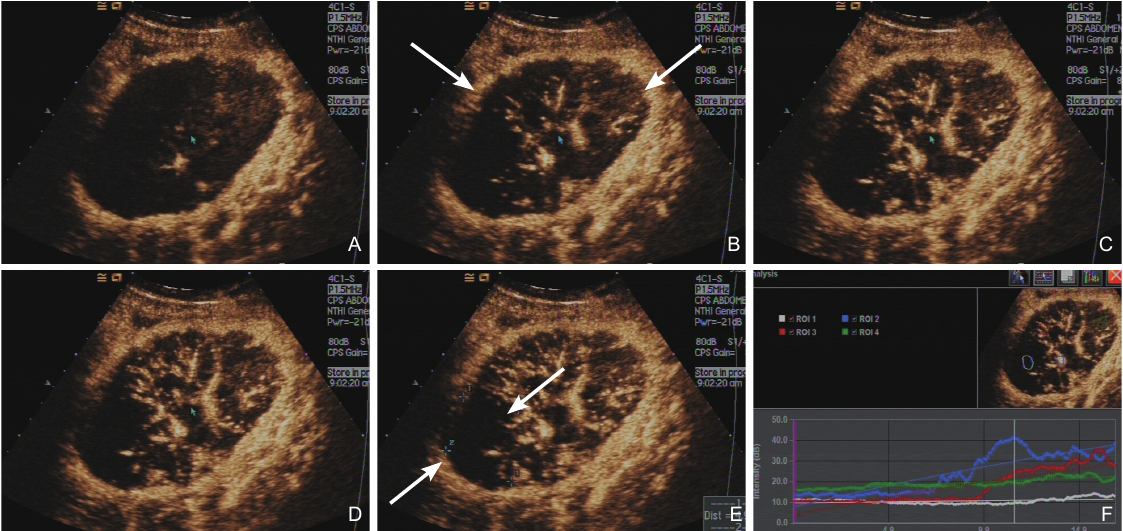
Figure 13 A 62-year-old man underwent kidney transplantation for chronic renal failure. Presented with oliguria for over 2 months and creatinine of 638umol/L. Real-time CEUS was used to see renal perfusion status. (A) Before contrast injection; (B) 12 sec after contrast injection, the capsule of the transplanted kidney was enhanced (white arrows); (C-D) 14 sec after injection, the main renal artery and the intrarenal segment arteries were enhanced gradually and visualized sequentially; (E-F) The upper pole of renal parenchyma identified a non-perfusion area (white arrows) measuring 4.9 × 4.3 × 4.0 cm and irregular enhancement within the kidney, consisting of a localized renal infarction and inhomogeneous hypoperfusion